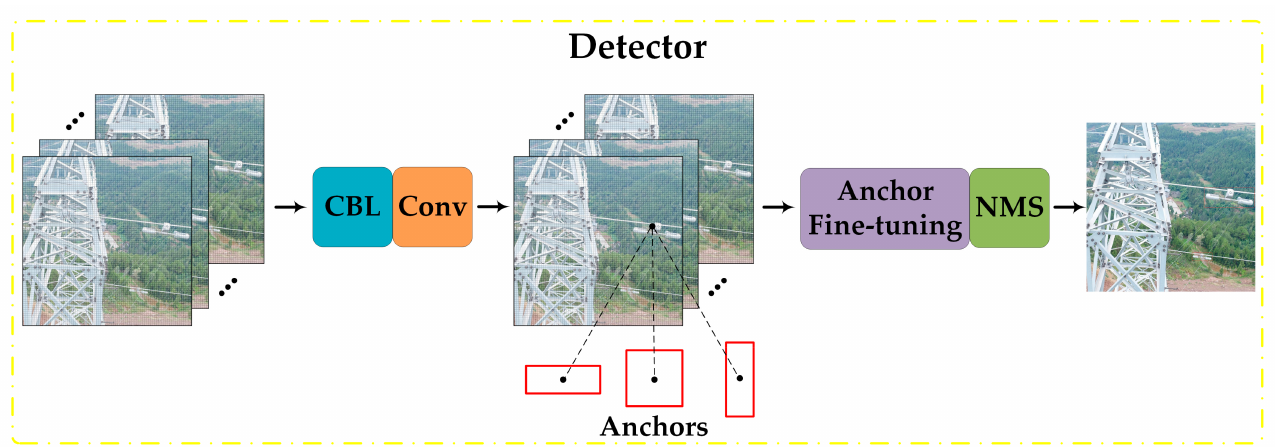
Figure 14. Architecture of the prediction branch.